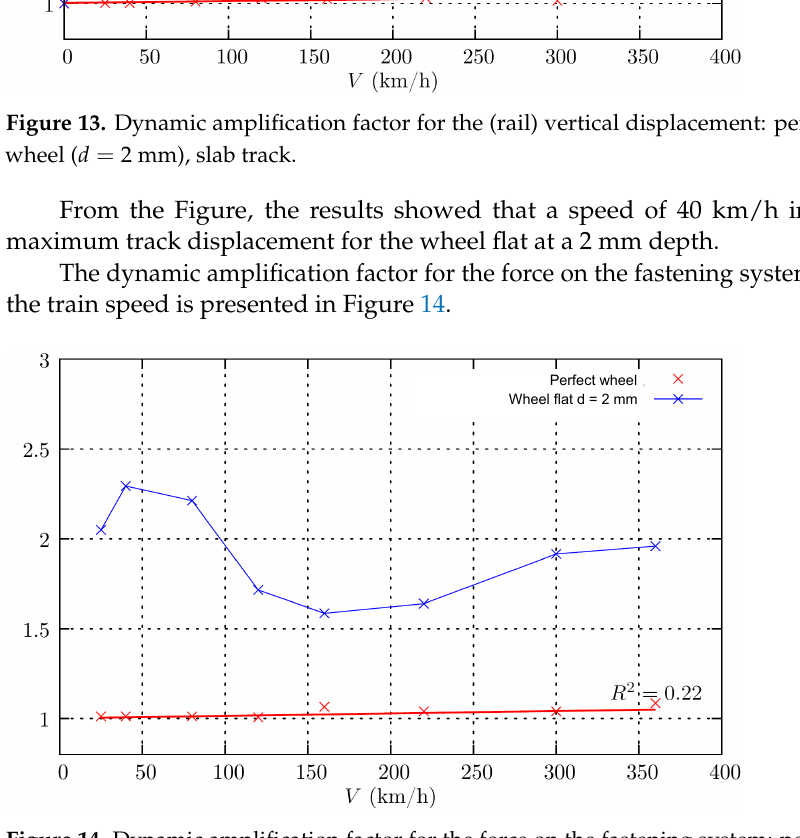
Figure 14. Dynamic amplification factor for the force on the fastening system: perfect wheel vs. flat wheel ( d = 2 mm), slab